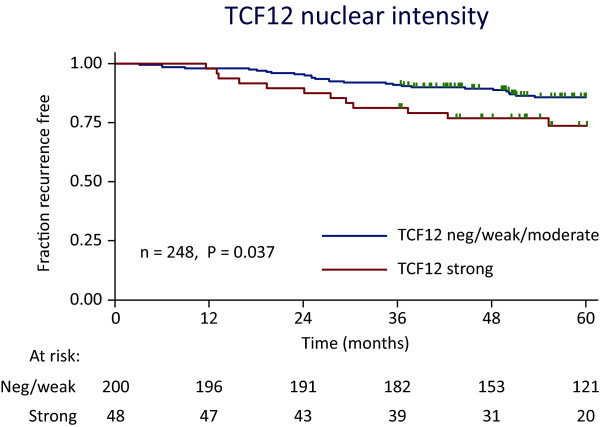
Kaplan-Meier curves for recurrence-free survival according to TCF12 staining intensity. IHC staining intensity of TCF12 on a colorectal stage II TMA was used to generate Kaplan-Meier curves for recurrence free survival. Intensity scores were divided in negative/weak/moderate versus strong staining intensity. The log-rank test was used to generate the p-value by comparing the survival curves. Number at risk are listed below the plot and censored samples are indicated with a vertical bar.